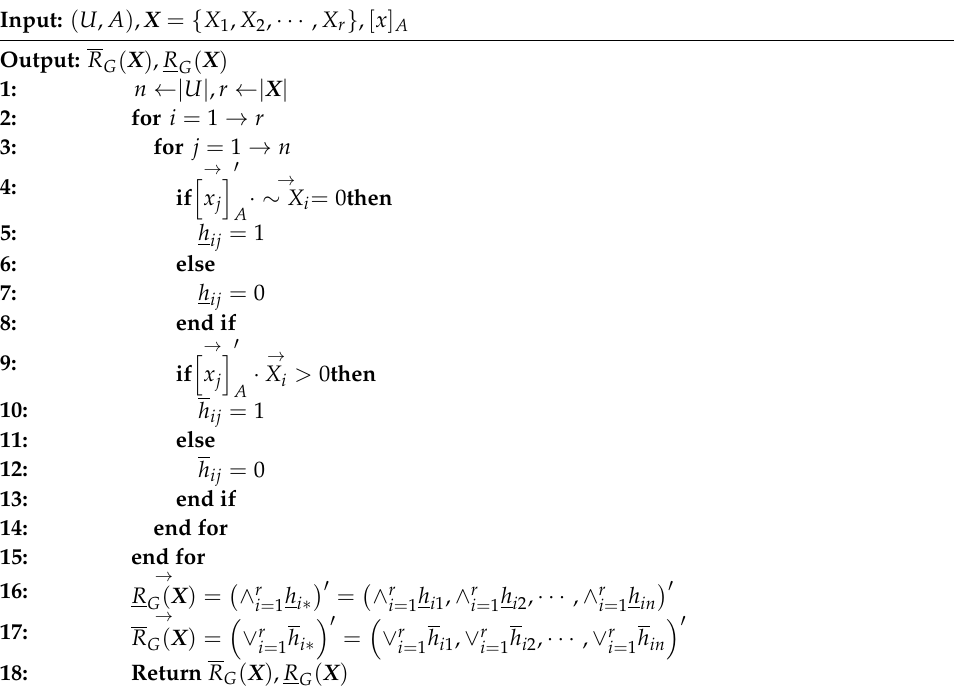
Algorithm 1. Computing Approximations of GMTRSs (CAG).